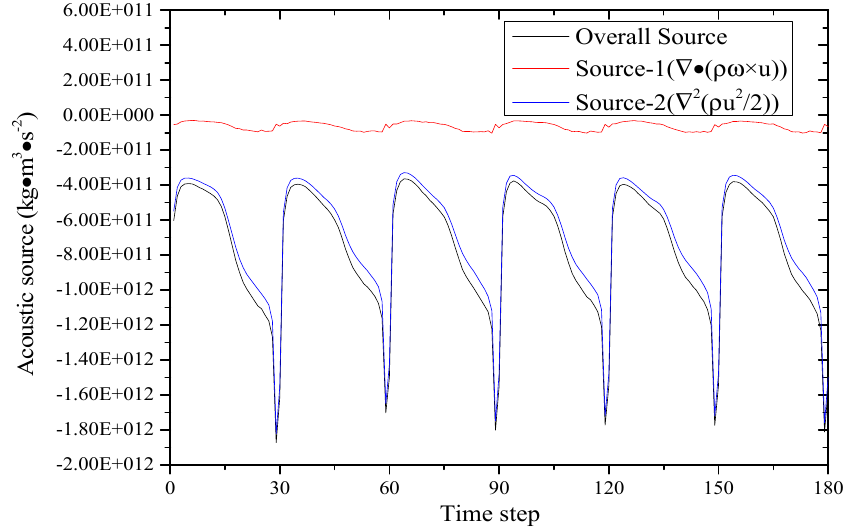
Figure 15. The fluctuation curves of di ff erent acoustic sources at 2900 rpm.